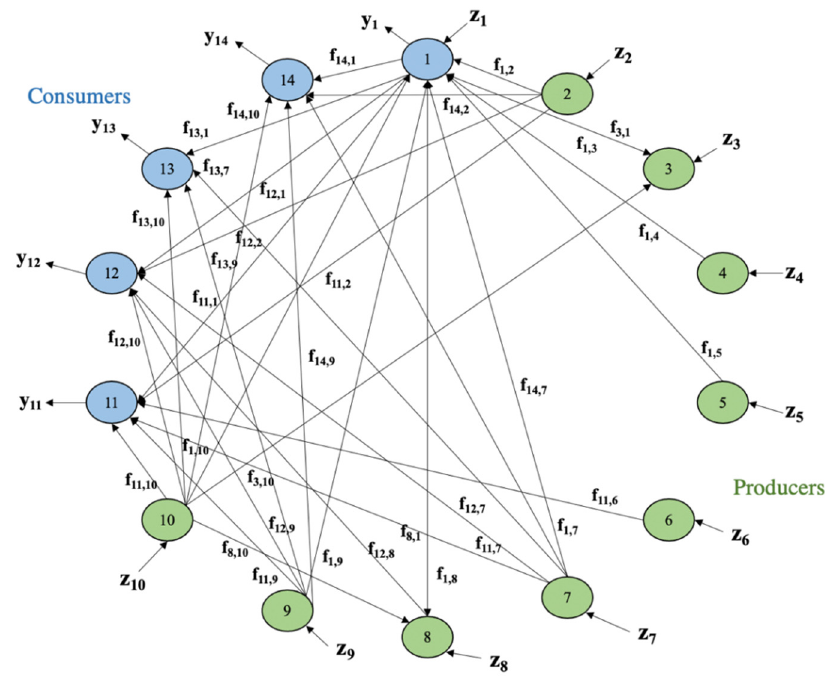
Figure 1. The U.S. energy industry’s 14 compartments, or actors in the energy network. The actors are defined as follows: (1) electricity sector, (2) solar, (3) nuclear, (4) hydroelectric, (5) wind, (6) geothermal, (7) natural gas, (8) coal, (9) biomass, (10) petroleum, (11) residential sector, (12) industrial sector, (13) transportation sector, and (14) commercial